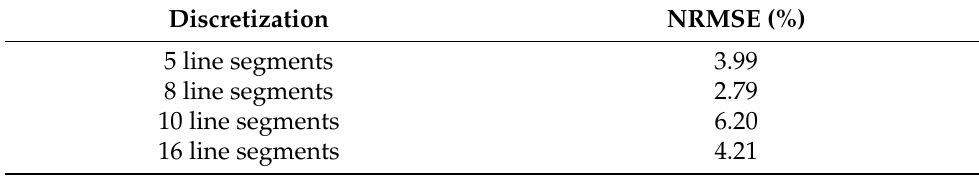
Table 2. NRMSE values for each velocity inlet discretization at the wave generation